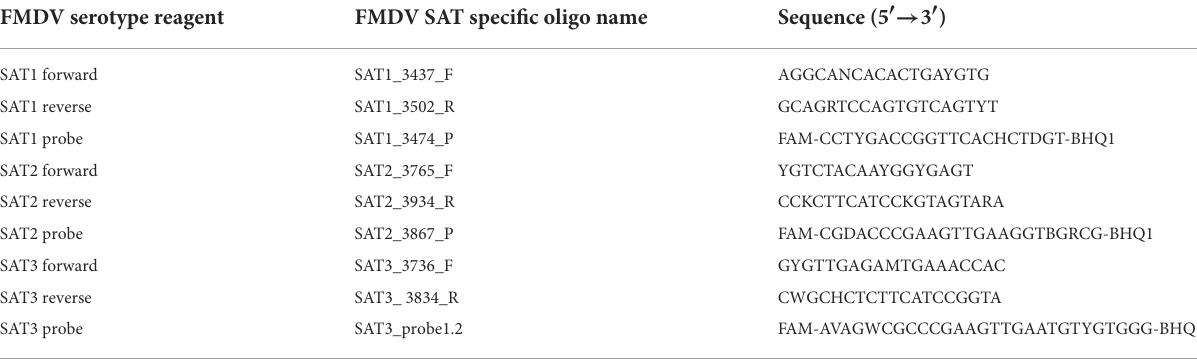
TABLE 2 FMDV SAT1, SAT2 and SAT3 serotype-specific rRT-PCR assay primers and probes. FMDV serotype